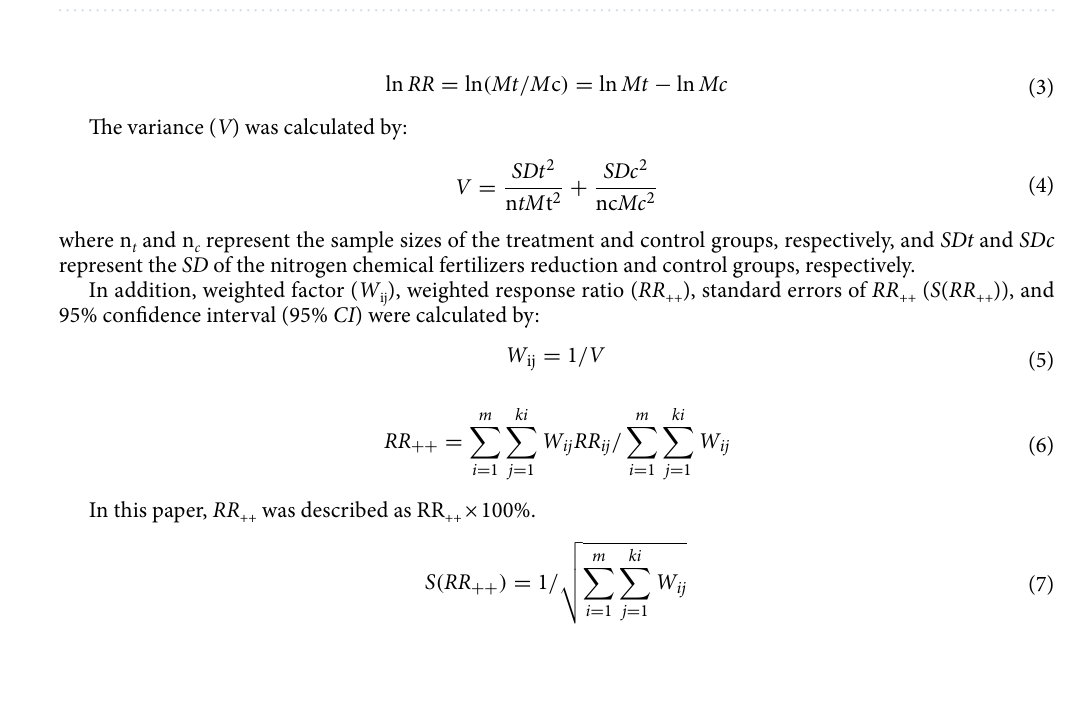
Figure 5. Flow chart of the present